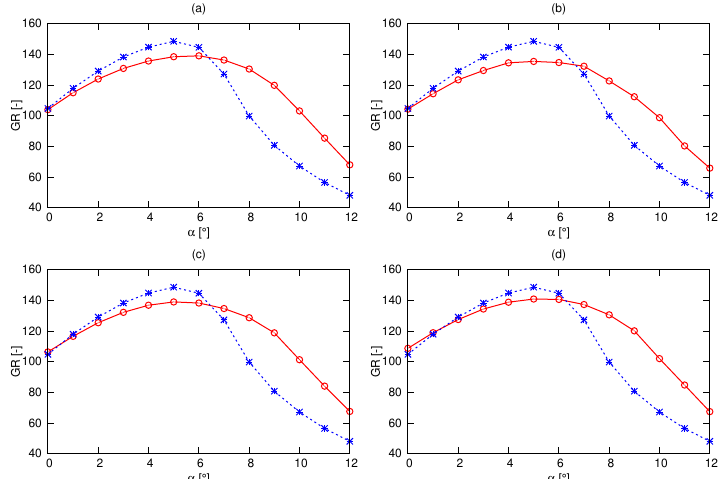
Figure 7. Reference and optimized hydrofoils of the first case of 3D optimization, where ( a ) is optimized hydrofoil HF-3D-1-1, ( b ) is optimized hydrofoil HF-3D-1-2, ( c ) is optimized hydrofoil HF-3D-1-3 and ( d ) is optimized hydrofoil HF-3D-1-4. The red solid lines denote the optimized hydrofoil and the blue dash-dot lines denote the original hydrofoil.